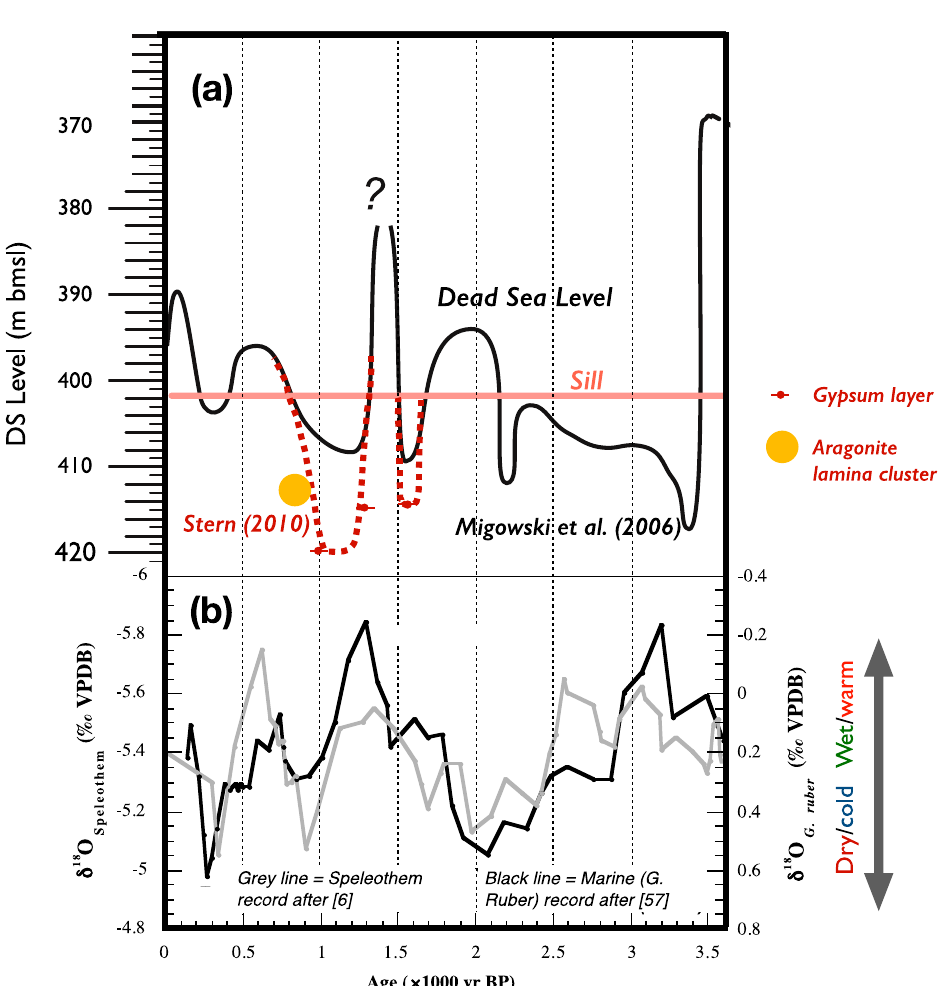
Figure 4. ( a ) The solid black line depicts the late Holocene Dead Sea level record reconstructed from a survey of several shore areas and dated by 14 C analysis of buried organic debris, as described in [27,47]. In dashed red lines are the modification made to the earlier curve after studying the Ein Kedem site that was exposed in recent lake level drops by [51]. The horizonal orange line marks the level of the Sill—a natural barrier that separates the lake into a deep northern part and shallow southern section. ( b ) The late Holocene smoothed curve of δ 18 O values measured in a Mediterranean sediment core close to the coast of southern Israel analyzed by Schilman et al. [55], together with the δ 18 O record retrieved from the Soreq Cave speleothems analyzed by Bar-Matthews and Ayalon [6]. Panel ( a ) is adapted from [42] and panel ( b ) from [7]. The time axis is in units of 1000 “years before present,” where the year 0 stands for 1950, 1 indicates the year 950 C.E., 2 is 50 B.C.E., etc.